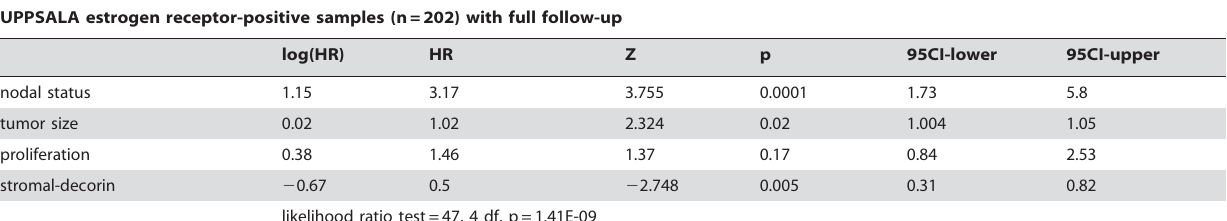
UPPSALA estrogen receptor-positive samples (n=202) with full